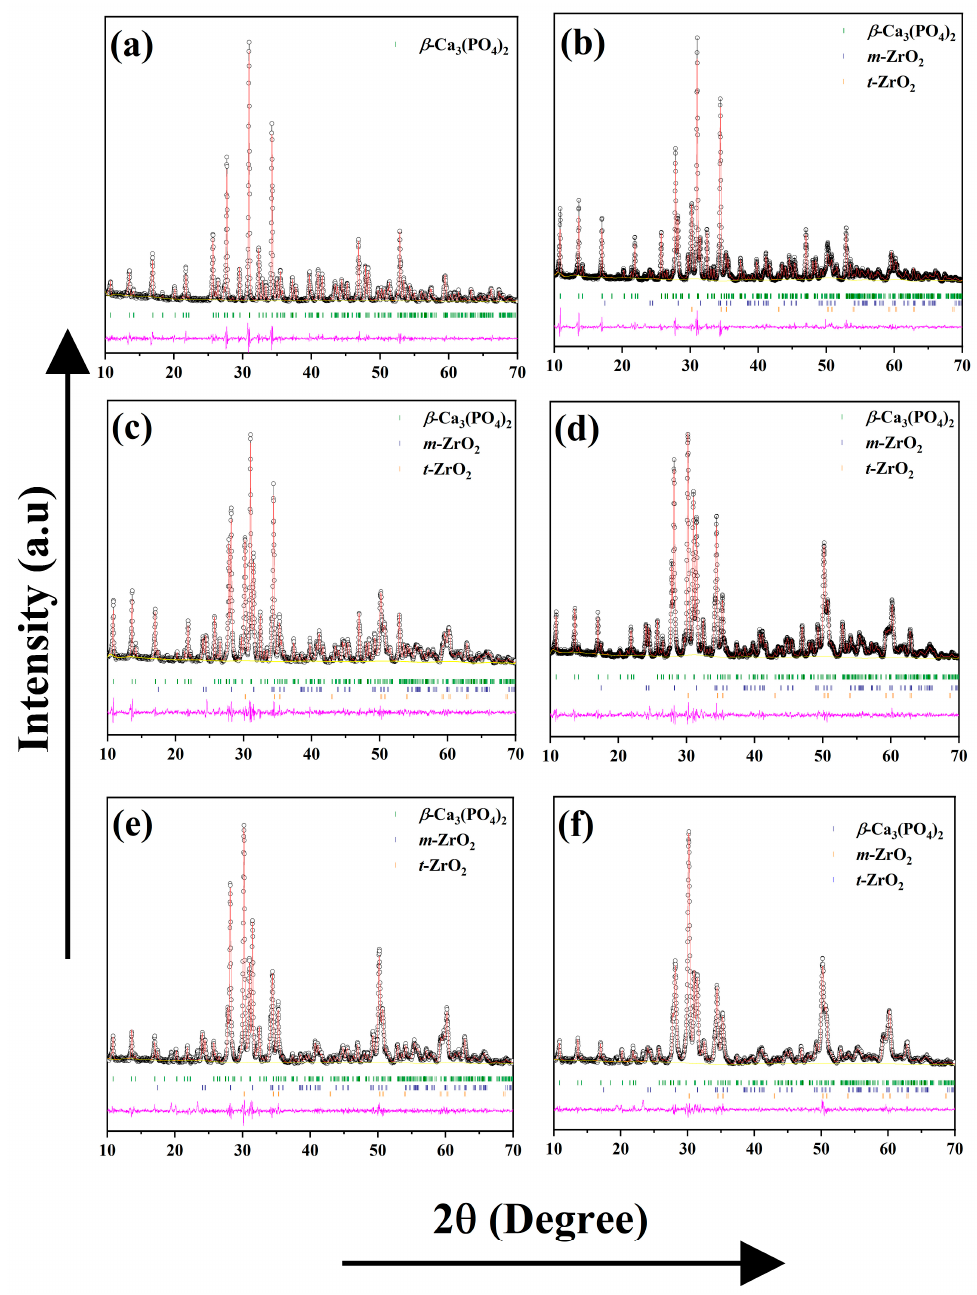
Figure 5. Rietveld refinement diffraction patterns for β -Ca 3 (PO 4 ) 2 –ZrO 2 composites at 1100 °C . ( a ) Pure TCP, ( b ) 1CPZ, ( c ) 2CPZ, ( d ) 3CPZ, ( e ) 4CPZ, and ( f ) 5CPZ. The calculated (red line), back- ground (yellow line), and difference (magenta), as well as the Braggs of β -Ca 3 (PO 4 ) 2 (olive lines), t- ZrO 2 (orange lines), and m- ZrO 2 (navy lines).